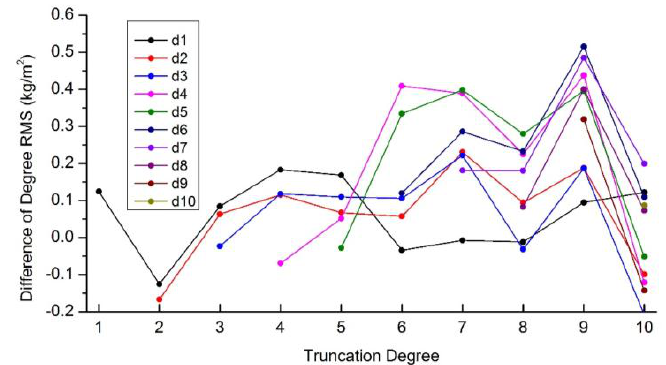
Figure 4. Degree RMS differences between coefficients inverted from the simulated displacements of 560 stations with and without data gaps and the reference values discussed in Section 2.1.